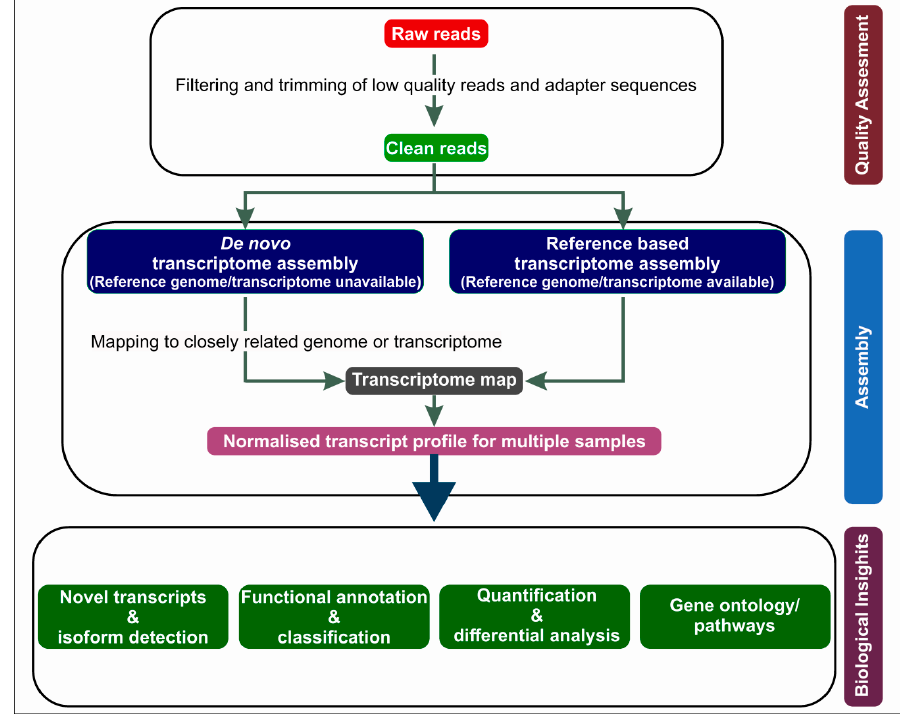
Figure 2. Schematic representation of the processing of data obtained from next-generation sequencing (NGS), by means of bioinformatics. Briefly, the raw reads obtained from NGS are subjected to quality assessment, and high-quality clean reads are further processed for transcriptome assembly. The assembled normalized transcriptome could be further explored for biological insights.